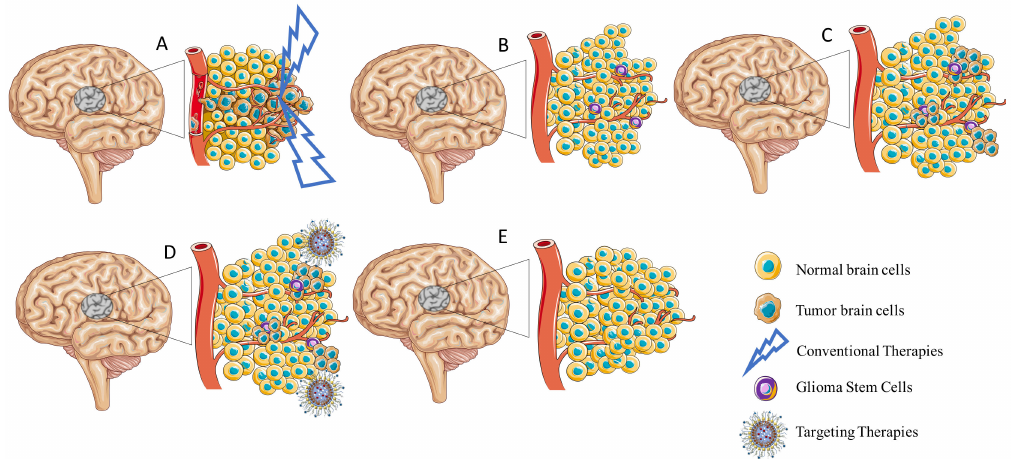
Figure 6. Influence of the targeting approach on GSC function. The application of conventional therapies ( A ) lead to resistance of GSCs ( B ). GSCs cells, which are present in the specific perivascular niches, restart their growth process and develop tumor cells, due to their high number of surface markers, differentiation markers, and distinctive stimuli, such as cytokines, growth factors and the angiogenesis process ( C ). In this context, a targeting approach strategy involving the binding to the surface markers or cytokines, which are responsible for tumor growth or cytokines inhibition, may be an excellent strategy against GSCs ( D ), avoiding tumor recurrence ( E ).